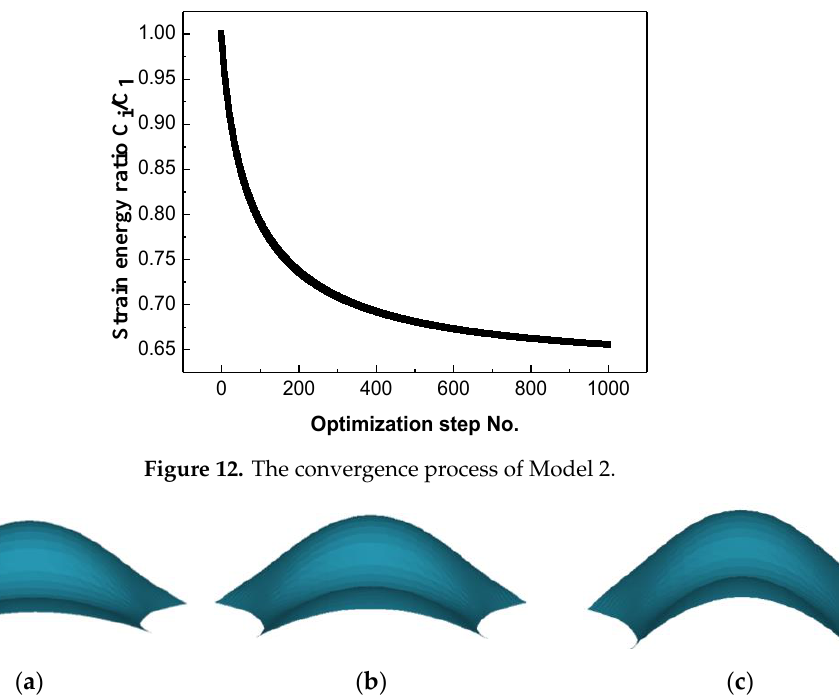
( b ) Figure 11. Layout of control points, mesh and the initial geometry of Model 2: ( a ) Layout of control points and mesh; and, ( b ) Initial guess shape.